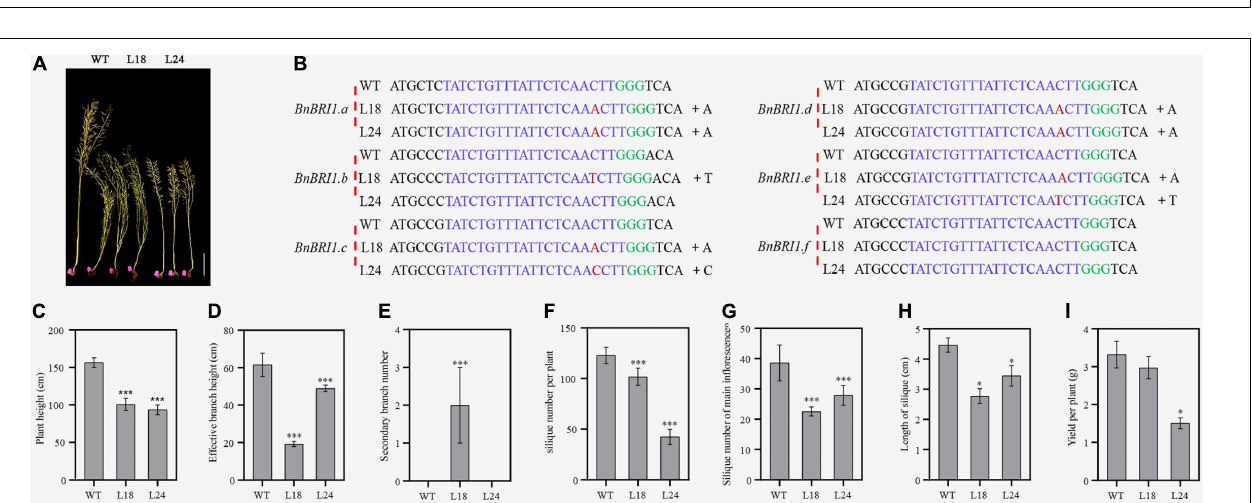
FIGURE 5 | Evolutionary analysis of BRI1 and BRI1-like receptor family and CRISPR/cas9 targeted BnBRI1 gene mutation. (A) Phylogenetic tree analysis of BRI1-like receptor family in B. napus and A. thaliana . (B) Expression profiles of BnBRI1 and BnBRL genes in different tissues. (C) CRISPR/Cas9 sgRNA targets the exon of BnBRI1 genes. The red box highlights the target sequences in six BnBRI1 homologous sequences. The protospacer adjacent motif (PAM) is indicated in the blue box. (D) Physical map of CRISPR/cas9 vector pHSE401 between the RB and LB. (E) Phenotypes of CRISPR/Cas9-edited BnBRI1 mutants during flowering of rapeseed. From left to right are WT (K407), L1 ∼ L4 strains, scale bars = 12 cm. (F) Pie chart of plant height from the gene edited Bnbri1 mutants in T 0 generation. The green, blue, and yellow indicates the percentage of extreme dwarf, dwarf, and semi-dwarf phenotypes, respectively.